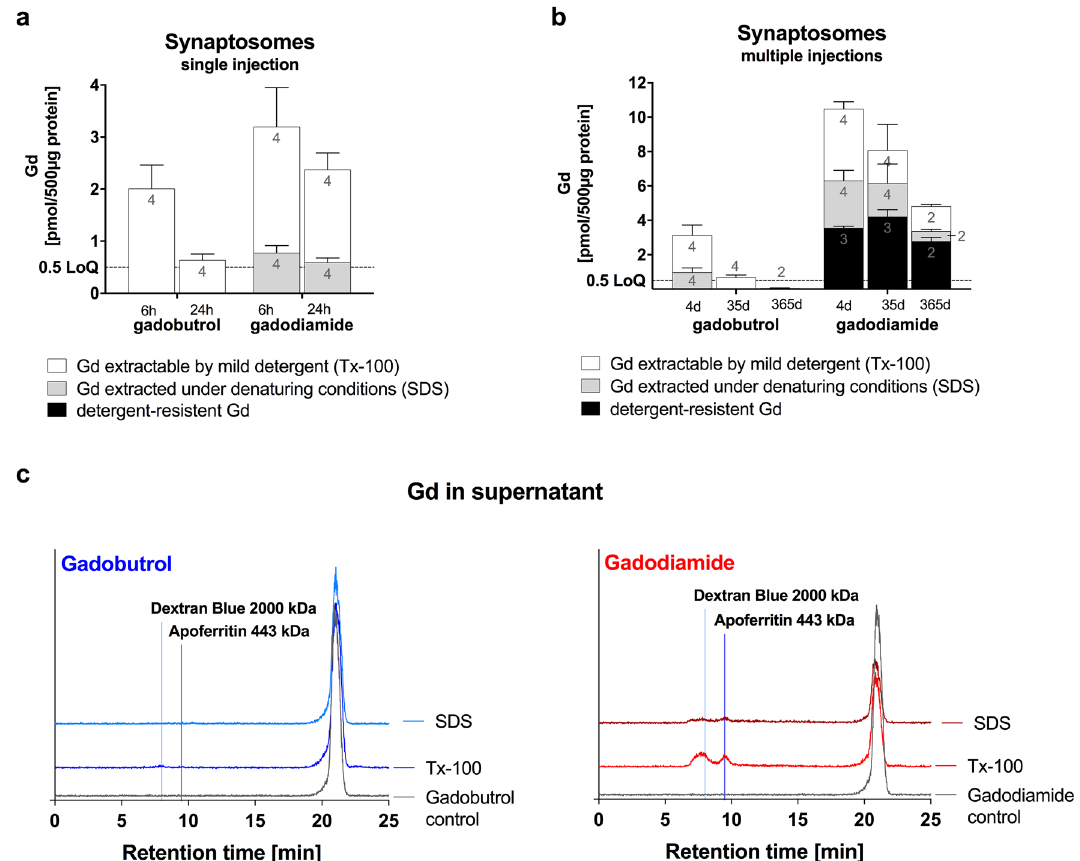
Figure 4. Detergent extraction of synaptosomes purified from GBCA treated animals. Synaptosomes were incubated either with 2% Triton X-100 or 0.5% SDS or detergent free buffer as a control and the resulting synaptosomal pellets were analyzed for Gd by ICP-MS. ( a ) Synaptosomal Gd in animals which received a single injection of GBCA (gadobutrol or gadodiamide, 1.8 mmol/kg BW) and were sacrificed after 6 and 24 h p.i. ( b ) Synaptosomal Gd in animals which received multiple injections of GBCA (gadobutrol or gadodiamide, 8 × 1.8 mmol/kg BW) and were sacrificed after 4, 35 and 365 days p.i. ( c ) The released Gd species in the extracts from synaptosomes of animals that received multiple injections of GBCA (4 days p.i.) were characterized by size exclusion chromatography (SEC)-ICP-MS. Chromatograms of extracted Gd species in comparison to a pure solution of gadobutrol (left panel) and gadodiamide (right panel). Note that for gadodiamide but not for gadobutrol injected animals additional Gd species with large molecular weight (shorter retention time) were observed; Data represent mean ± SD; n is indicated in the